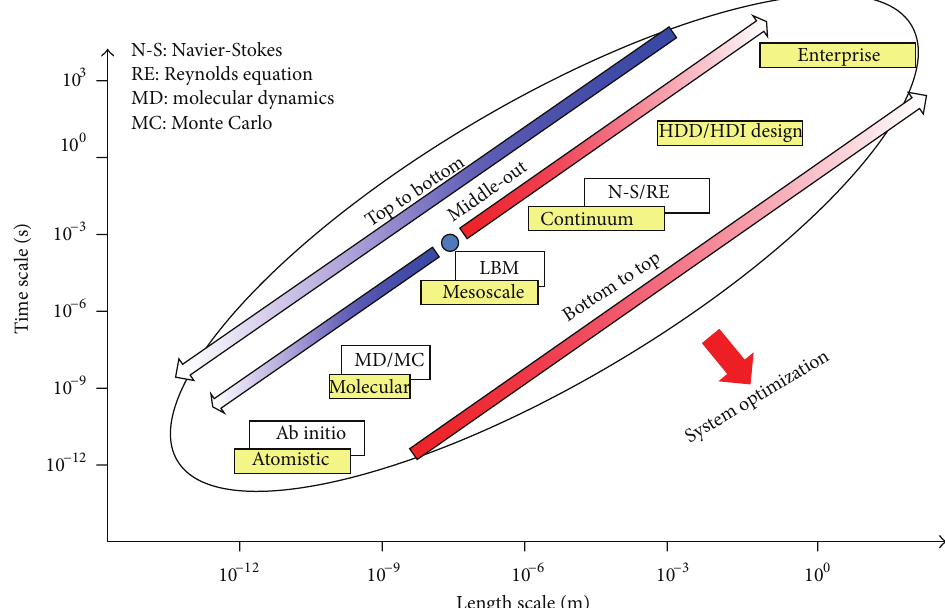
Figure 1: An illustration of the several multiscale modeling